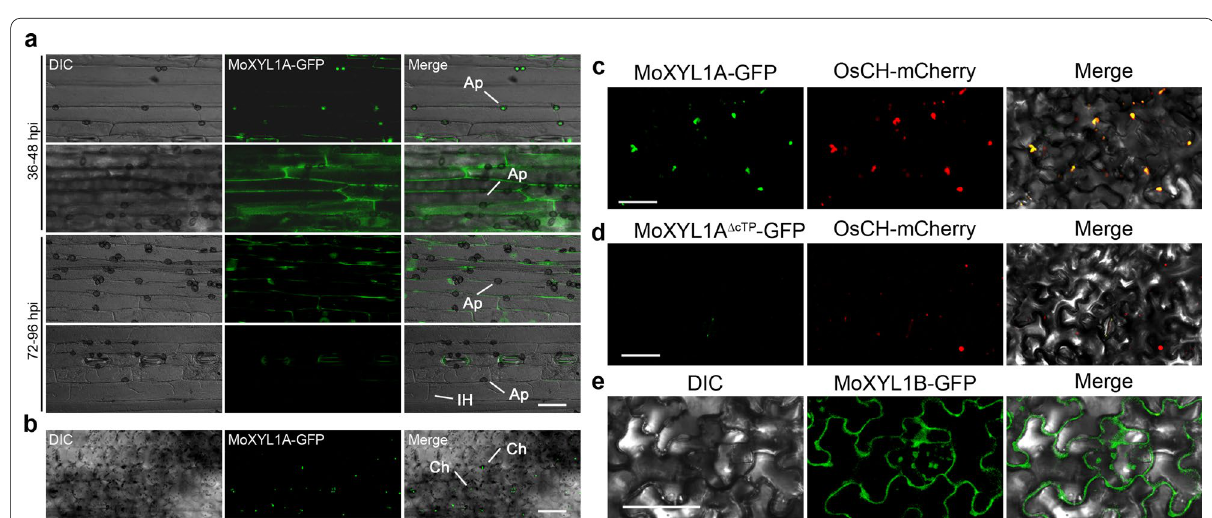
Fig. 5 MoXYL1A accumulated at the Chloroplasts of barley and tobacco seedlings. a Showed the localization pattern of MoXYL1A-GFP during M. oryzae interaction with barley host during early (24–48-hpi), and late (72–96-hpi) stages of pathogen-host interaction. b The micrograph revealed the accumulation of MoXYL1A-GFP to the chloroplast of leaf epidermal tissues of barley leaves at 72-hpi. Scale bar confirmed the co-expression of (MoXYL1A-GFP) and the chloroplast marker (ChCpn10) in the chloroplas of agro-infiltrated tobacco seedlings. Scale bar 10 µm. e Showed distortions in the localization pattern of MoXYL1A- ∆ctp -GFP. The MoXYL1A- ∆ctp -GFP signals accumulated at the membrane = or extracellular regions of agrobacterium infiltrated tobacco seedlings at 48-hpi. GFP was excited at 488 nm and RFP was excited at 561 nm. Scale bar 20 =